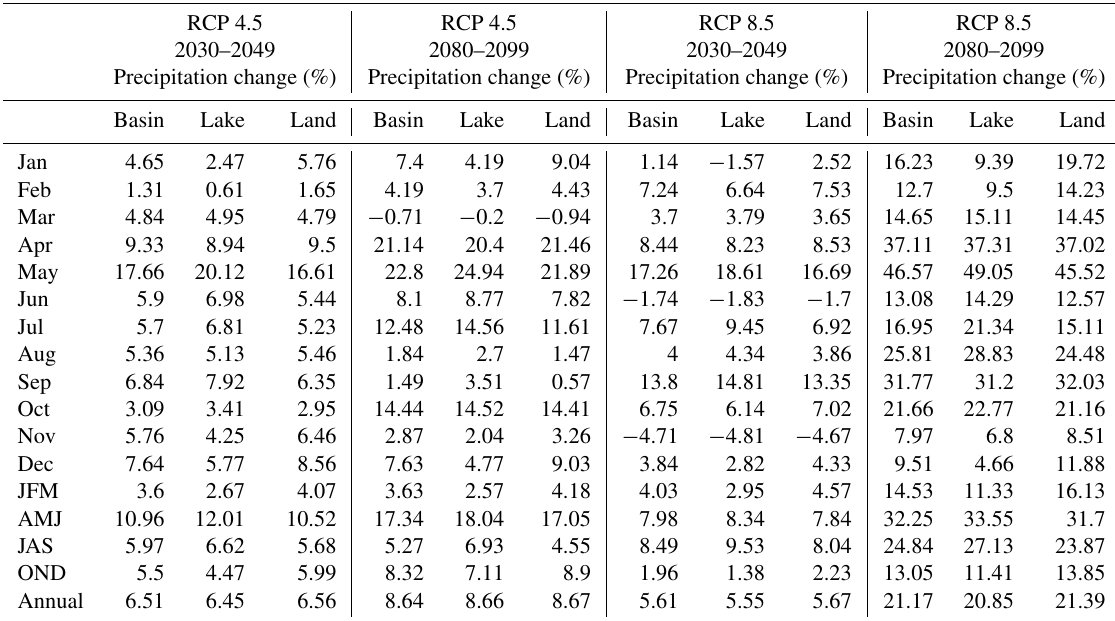
Table 4. GLARM-EA3 projected changes in monthly, seasonal, and annual precipitation over land, lake, and the Great Lakes basin in the mid-century (2030–2049) and late century (2080–2099) for the RCP 4.5 and RCP 8.5 scenarios, relative to the present-day climate (2000–